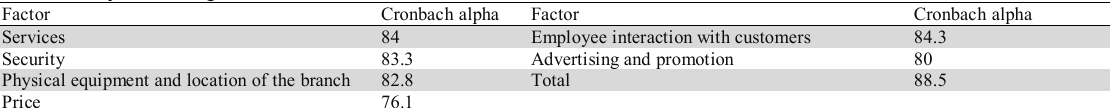
Reliability of the questionnaire